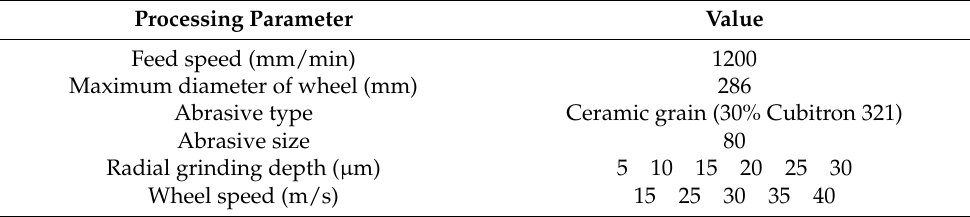
Table 4. Experimental